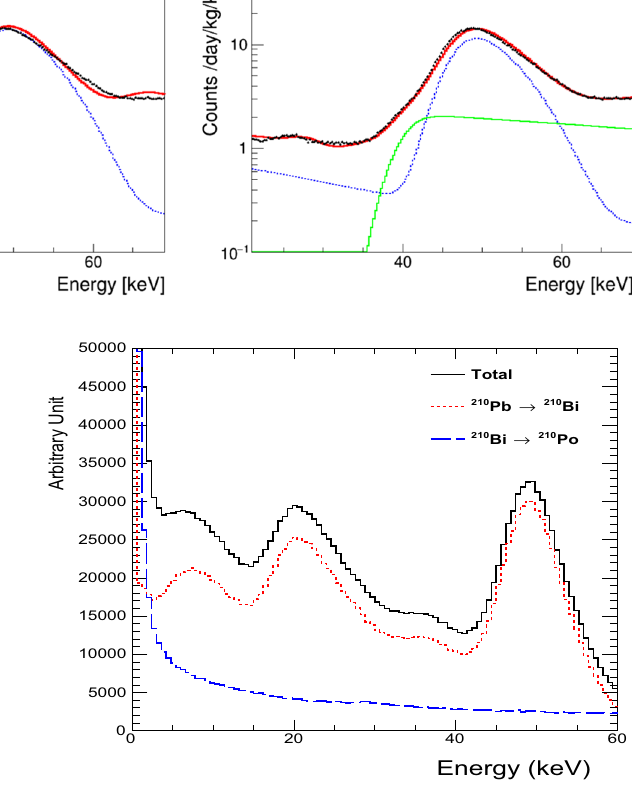
Fig. 4 Low-energy spectra due to the beta decays of 210 Pb that are distributed within the surface thickness of 1 µ m in the crystal. Further details are given in Sect.